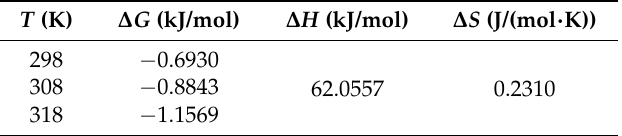
Table 5. Thermodynamic parameters for the sorption of Hg(II) on MPy-600.